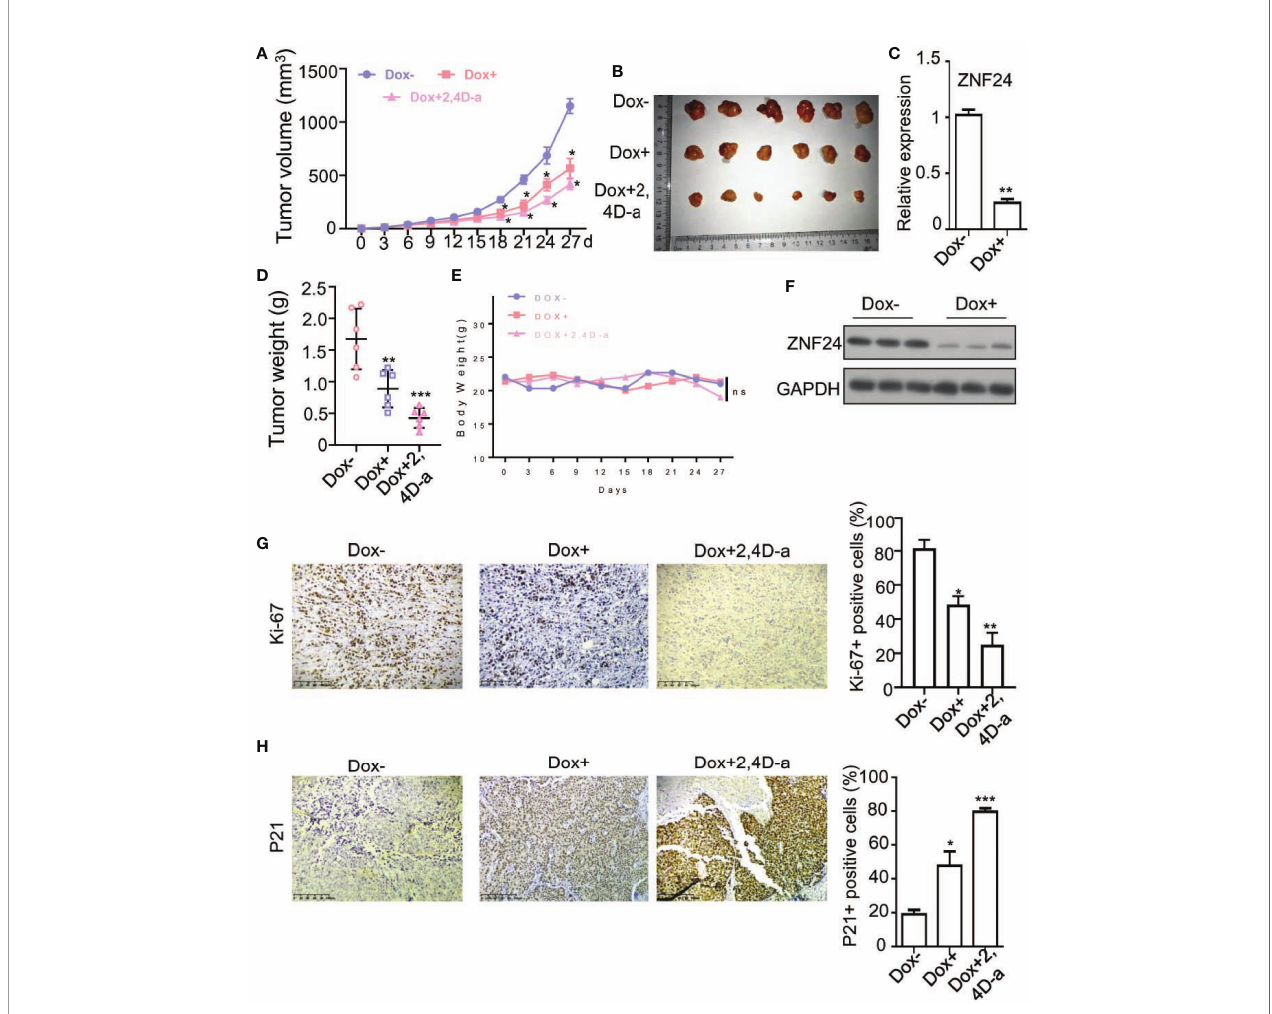
FIGURE 6 | ZNF24 and 2,4-Da inhibited THCA xenografted tumors growth in nude mice. (A, B, D) The growth and weight of DOX or 2,4-Da exposed tumor samples was signi fi cantly inhibited relative to controls. We measured tumor growth at intervals of 2 days by measuring its diameter with Vernier caliper. (C) The Real Time PCR analysis of ZNF24 on ex vivo tumor extracts. (E) 2,4 Dia or DOX made no difference to the mouse body weight measured at intervals of 5 days. (F) Protein expression level of ZNF24 of THCA xenografted tumors of nude mice treated with DOX (DOX+) or without DOX (DOX-). (G, H) IHC staining of THCA xenografted tumors of nude mice treated with DOX (DOX+), DOX+2,4-Da or without DOX (DOX-), indicated antibodies were added during IHC staining assay. Values are obtained from three independent assays, while unpaired t-test was used for analysis. Error bars=SD. * P < 0.05; ** P < 0.01; *** P <